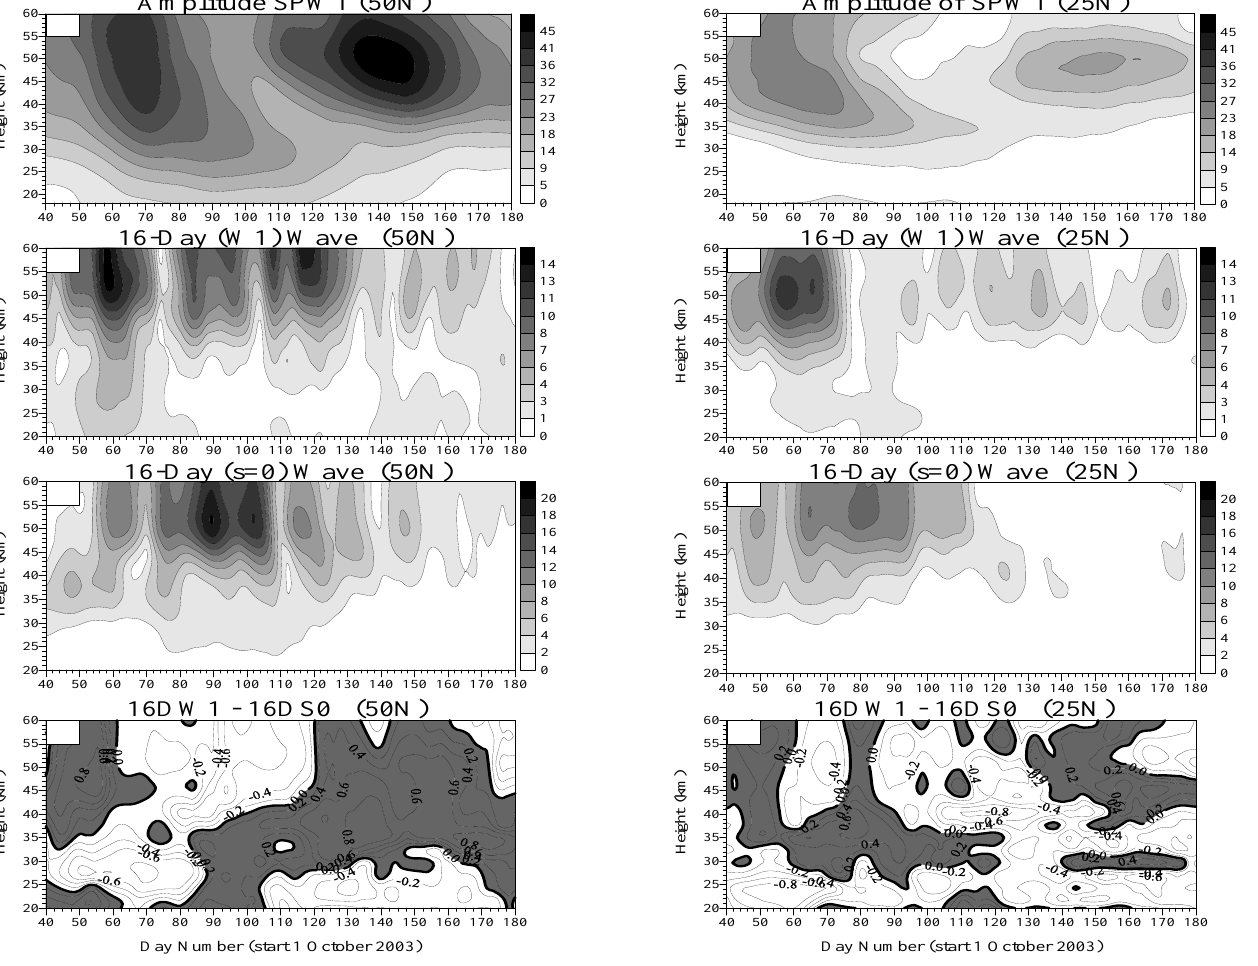
Figure 7 Fig. 7. Height-time cross sections of the amplitudes of: the primary SPW1 (upper row of plots), the 16-day W1 primary wave (second row of plots) and the 16-day ( s =0) secondary wave (third row of plots) at 50 ◦ N (left column of plots) and 25 ◦ N (right column of plots) for the period of time November 2003–March 2004. The bottom row of plots shows height-time cross sections of the cross-correlation coefficients between the amplitudes of the 16-day W1 wave and the 16-day ( s =0) secondary wave at 50 ◦ N and 25 ◦